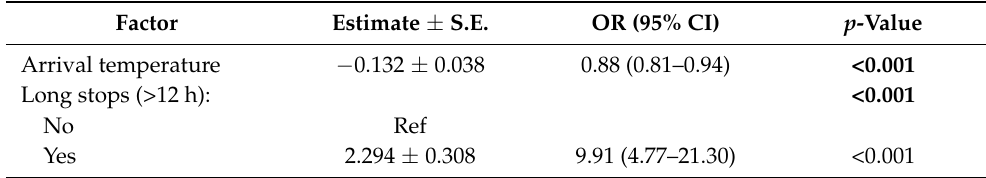
Table 14. Injured head/neck—final multiple regression model for the dummy dependent variable of presence/absence of injuries on the head and/or neck of horses at arrival at the slaughterhouse. Data are presented as estimates and standard errors (S.E.) of the effect, odds ratio (OR), confidence interval (95% CI), and p -value. Bold p -values refer to the statistical significance or trend towards the significance of the predictive variable in the model; the significance of a category against the reference is reported in regular